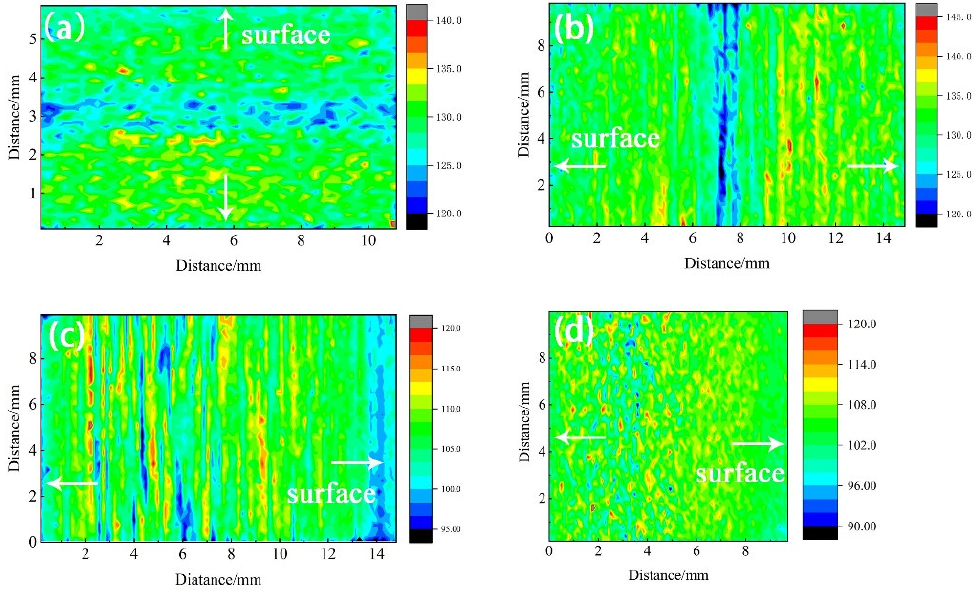
Figure 9. Hardness mapping of 7B05 aluminum alloy section: ( a ) T4-6; ( b ) T4-15; ( c ) T5-15; ( d ) T5-10.